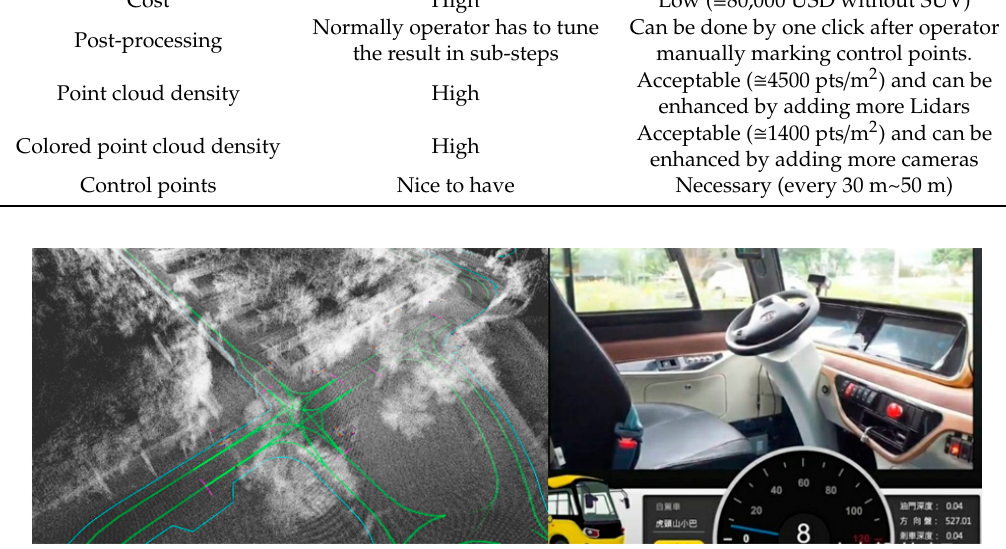
Figure 23. HD map established by color point cloud and vectors for use by an autonomous bus in the test area.